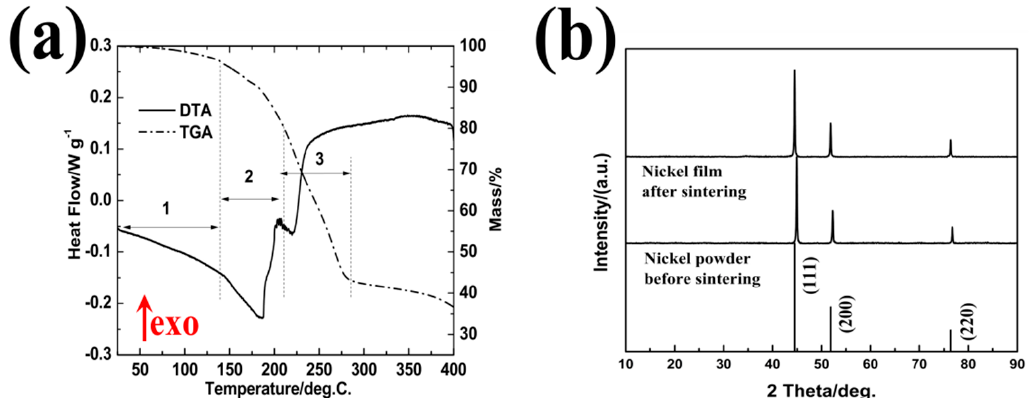
Figure 5. ( a ) Thermogravimetric analysis (TGA) and Differential thermal analysis (DTA) of synthesized nickel ink, ink is tested in Ar with temperature rise rate: 5 K/min; ( b ) XRD patterns of nickel before and after sintering.